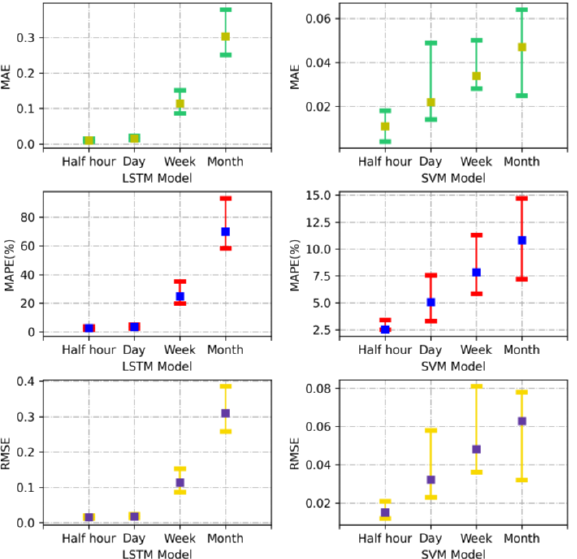
Figure 13. Error evaluation index values and error range for four scenarios of LSTM and SVM. Range of MAE values and values for four prediction scenarios for both algorithms among the test dataset ( first row ); Range of MAPE values and values for four prediction scenarios for both algorithms among the test dataset ( second row ); Range of RMSE values and values for four prediction scenarios for both algorithms among the test dataset ( third row ). Table 5. Model metric for two algorithms in various scenarios.